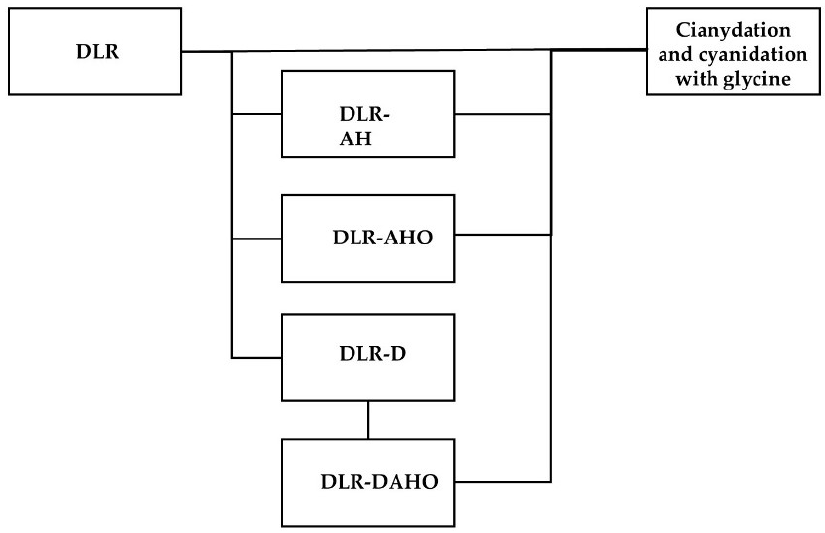
Figure 1. Experimental test sequence.